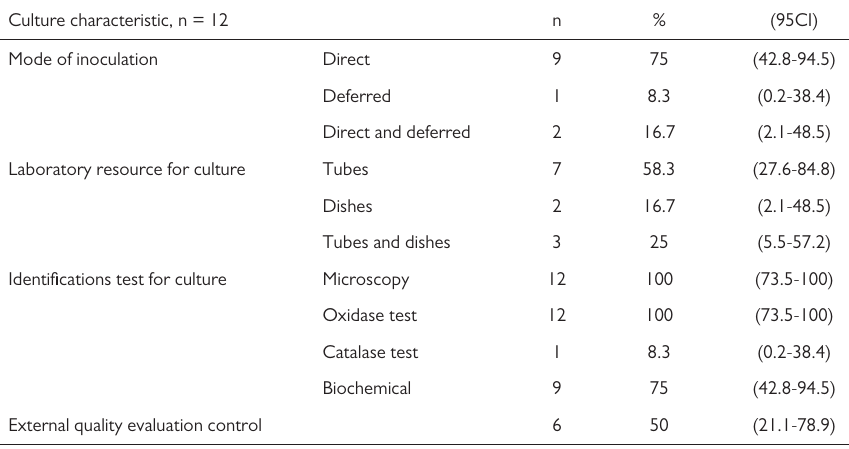
Table4. Performance Characteristics of Neisseria Gonorrhoeae Culture in Regional STI Clinics,